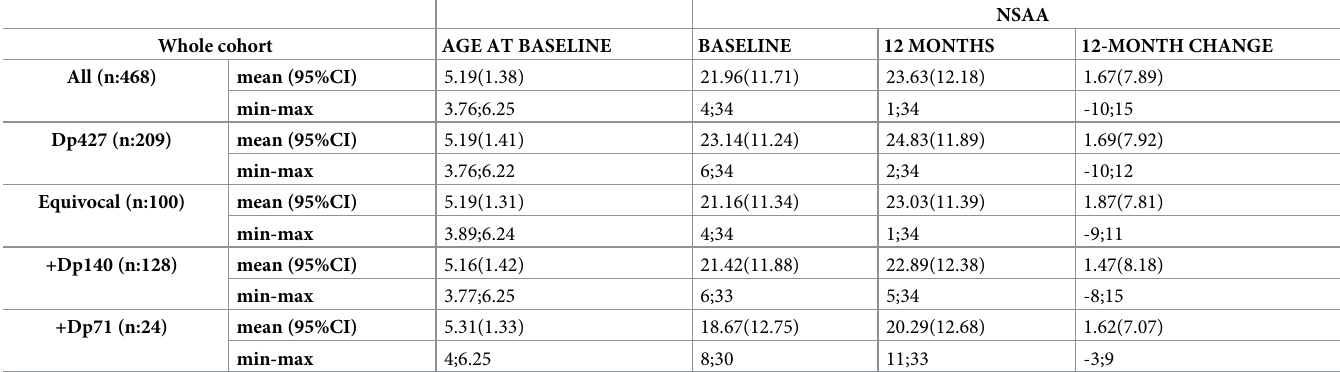
Table 4. Summary of baseline characteristics at baseline, 12-month, and changes over 12 months, subdivided by brain dystrophin